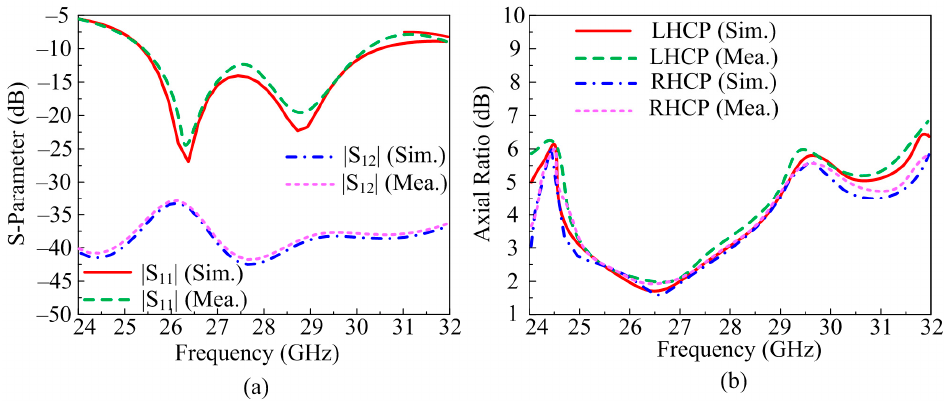
Figure 16. Comparison of MIMO antenna with inverted structure placement of element ( a ) scattering parameters ( b ) axial ratio.